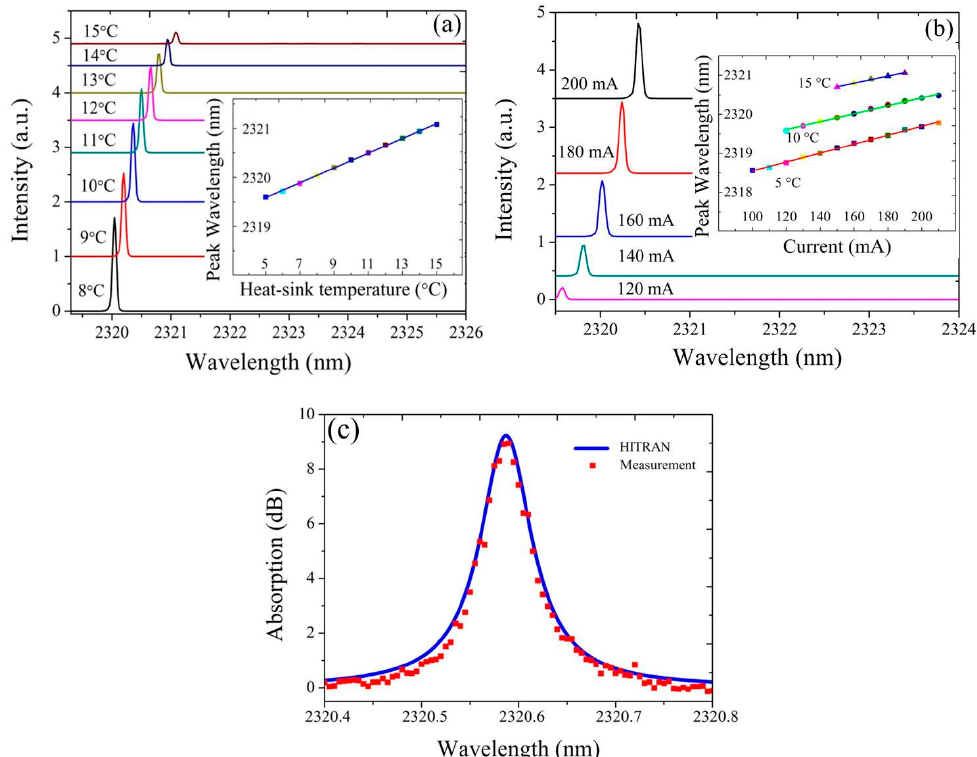
Figure 6. ( a ) Evolution of the DFB laser emission spectrum with increasing heat-sink temperature under 190 mA bias current, ( b ) with increasing bias current at 5 °C. The inset figure shows the 190 mA bias current, ( b ) with increasing bias current at 5 ◦ C. The inset figure shows the dependence of dependence of the lasing wavelength on ( a ) temperature and ( b ) bias current at 5 °C, 10 °C, 15 °C; ( c ) the lasing wavelength on ( a ) temperature and ( b ) bias current at 5 ◦ C, 10 ◦ C, 15 ◦ C; ( c ) direct TDLAS direct TDLAS measurement of CO and the corresponding HITRAN spectrum. measurement of CO and the corresponding HITRAN